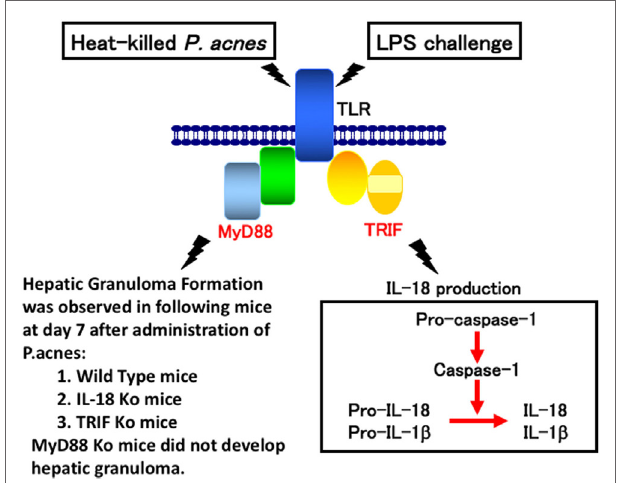
FigURe 1 | A proposal model for lipopolysaccharide (LPS)-induced liver injury in Propionibacterium acnes ( P. acnes )-primed and LPS-challenged mice. Wild-type mice or mice deficient for interleukin (IL)-18, MyD88, or TRIF were administered with heat-killed P. acnes and examined for their hepatic granuloma formation at day 7 after this treatment. Only P. acnes -primed MyD88 did not develop hepatic granuloma at day 7 after treatment, suggesting that P. acnes treatment induces hepatic granuloma in a MyD88-dependent manner, but TRIF-independent manner. Although TRIF-deficient mice normally developed hepatic granulomas after P. acnes treatment, they could not release IL-18 or develop liver injury, suggesting that LPS TRIF-dependently activated caspase-1 via NLRP3 inflammasome. And, resultant IL-18 induces liver injury by induction of interferon- γ , FasL, and tumor necrosis factor- α